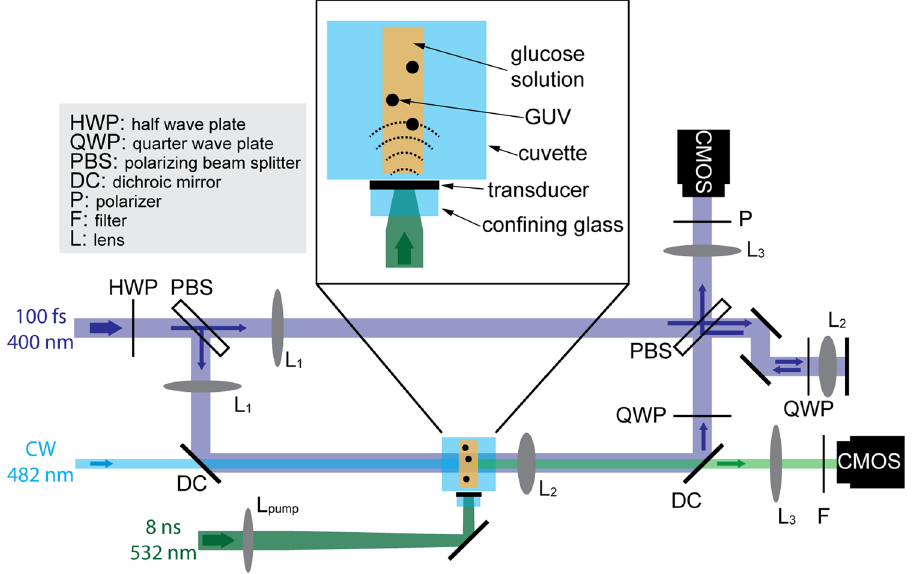
Figure 3. Apparatus for analyzing photoacoustic waves interacting with GUVs. Nd:YAG 532-nm pump laser pulses are totally absorbed by the piezophotonic transducer that generates ultrasound pulses. A frequency- doubled Ti:sapphire femtosecond laser pulse is split in reference and sample arms and their interference is recorded by a camera. Another camera is used to detect the fluorescence of FITC-dextran resulting from excitation by a CW laser. The zoom of the 1.5 × 1.5 cm polished quartz cuvette shows details of the assembly of the transducer film. The observation window is 7 to 9 mm from the plane of the transducer film.